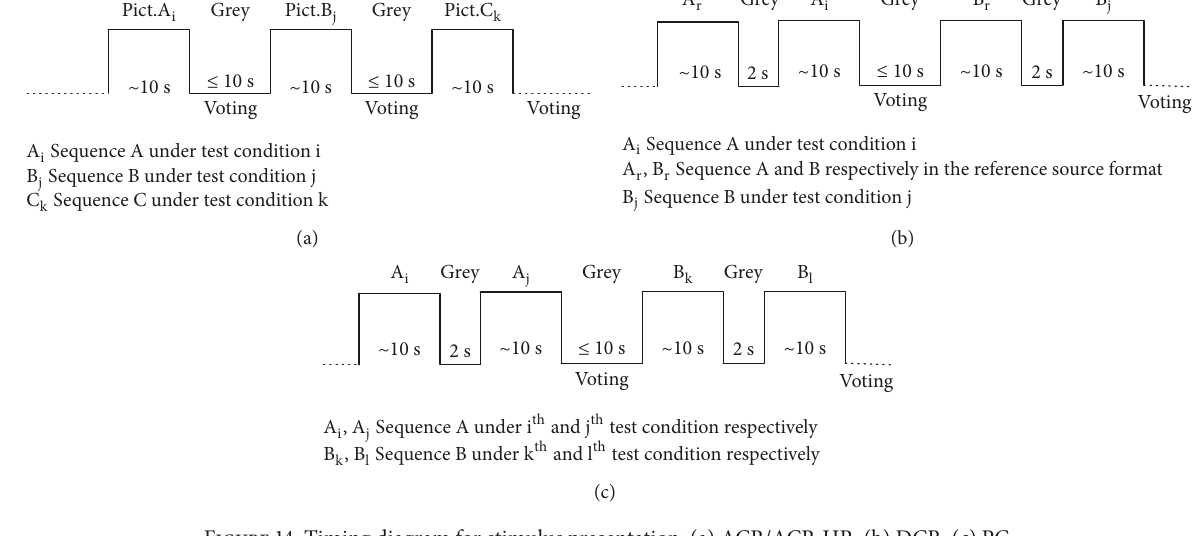
Figure 14: Timing diagram for stimulus presentation: (a) ACR/ACR-HR, (b) DCR, (c) PC. Table 2: Relevant video details.